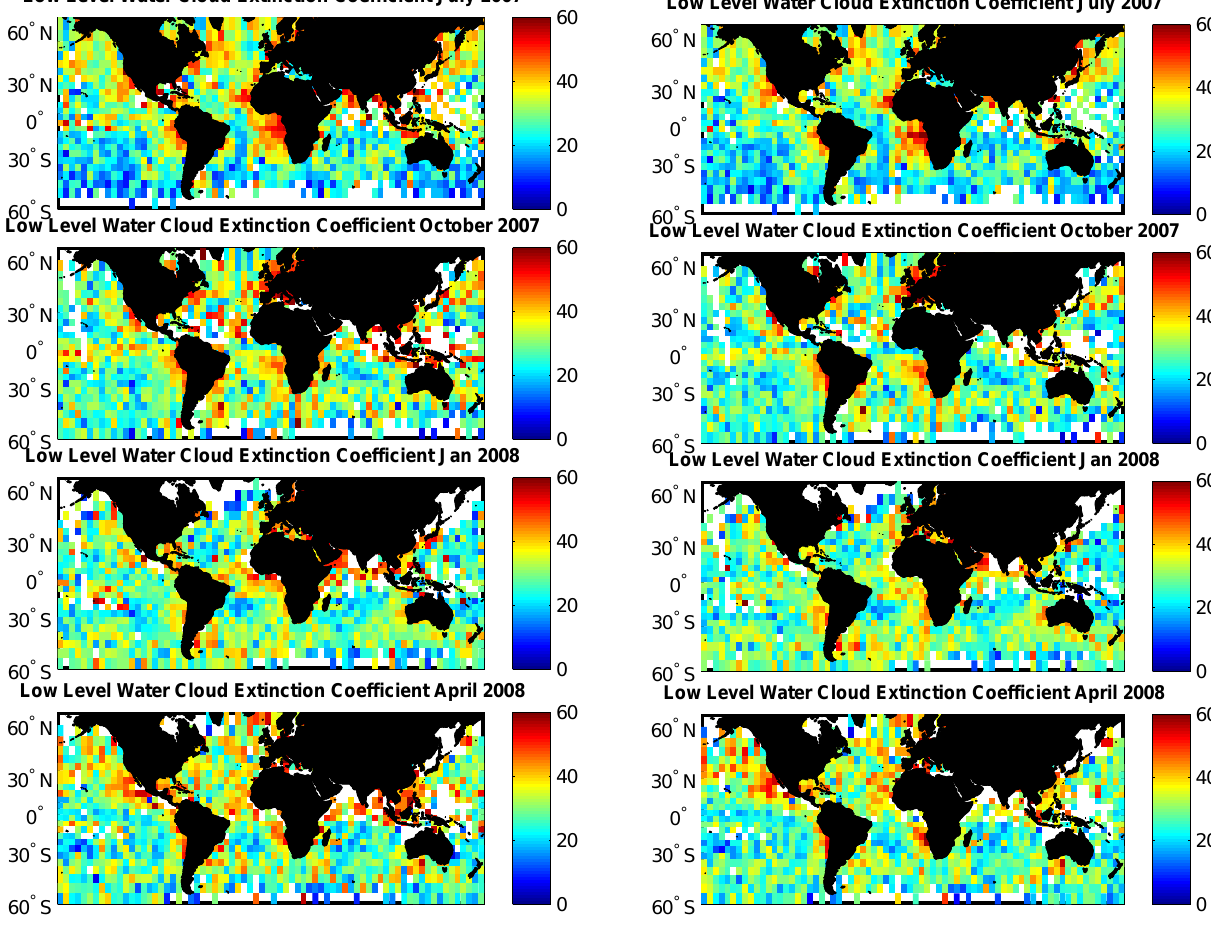
Fig. 5. The global distribution of Low level water cloud mean extinction coefficient at different months derived from the slope method (right) and Hu’s method (left).